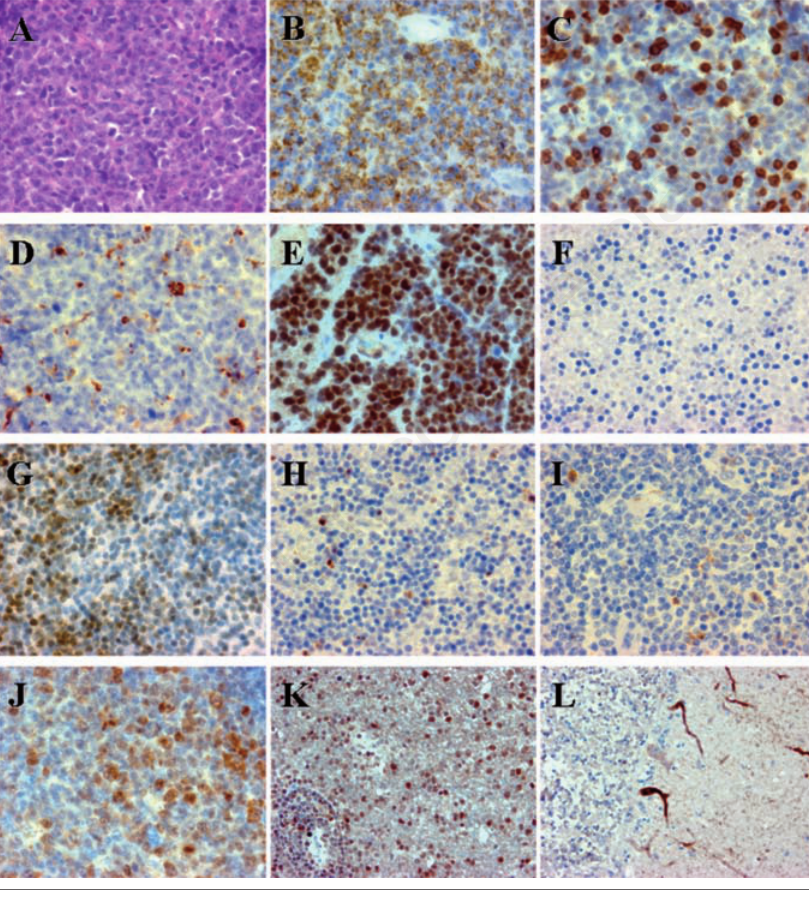
Figure 1. Immunohistochemical stainings of specimen E582: Haematoxylin & Eosin staining (A) shows densely packed lymphoid tumor cells, which are positive for CD20 (B). Reactive CD3 positive T cells (C) and CD68 positive microglial cells (D) are found within the tumor mass. CD20 positive tumor cells show extensive expression of BAFF (E) and weak to moderate expression of BAFF-R (G), BCMA (H) and TACI (I). No expres- sion of APRIL (F) was found in this specimen. Tonsil tissue served as positive control of anti-BAFF staining (J). Validation of anti-BAFF staining using a second antibody in tumor specimen E236 (K). Cerebellar tissue was used as positive control of anti-APRIL staining (L). Original magnification ¥ 200 (K, L), ¥ 400 (A-J).